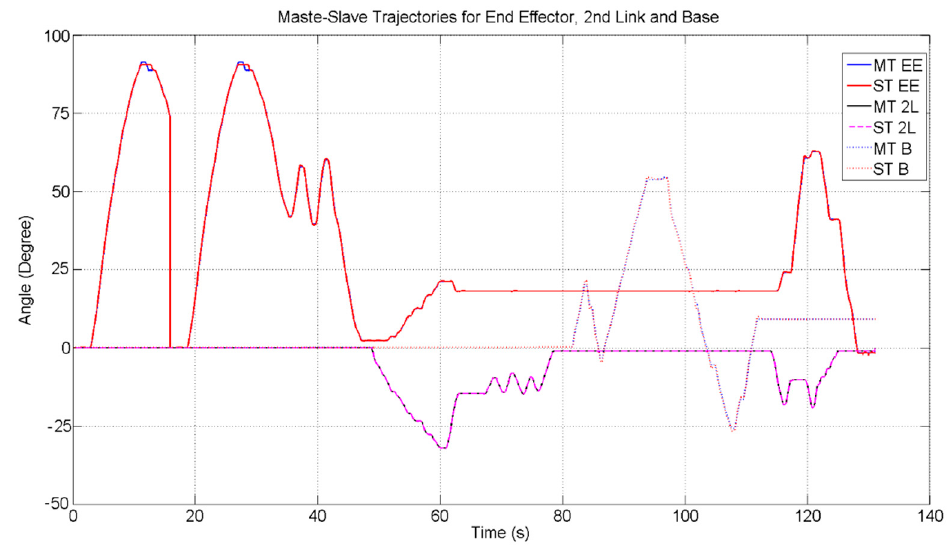
Figure 23. Master–slave trajectories for end effector, 2nd link and base.